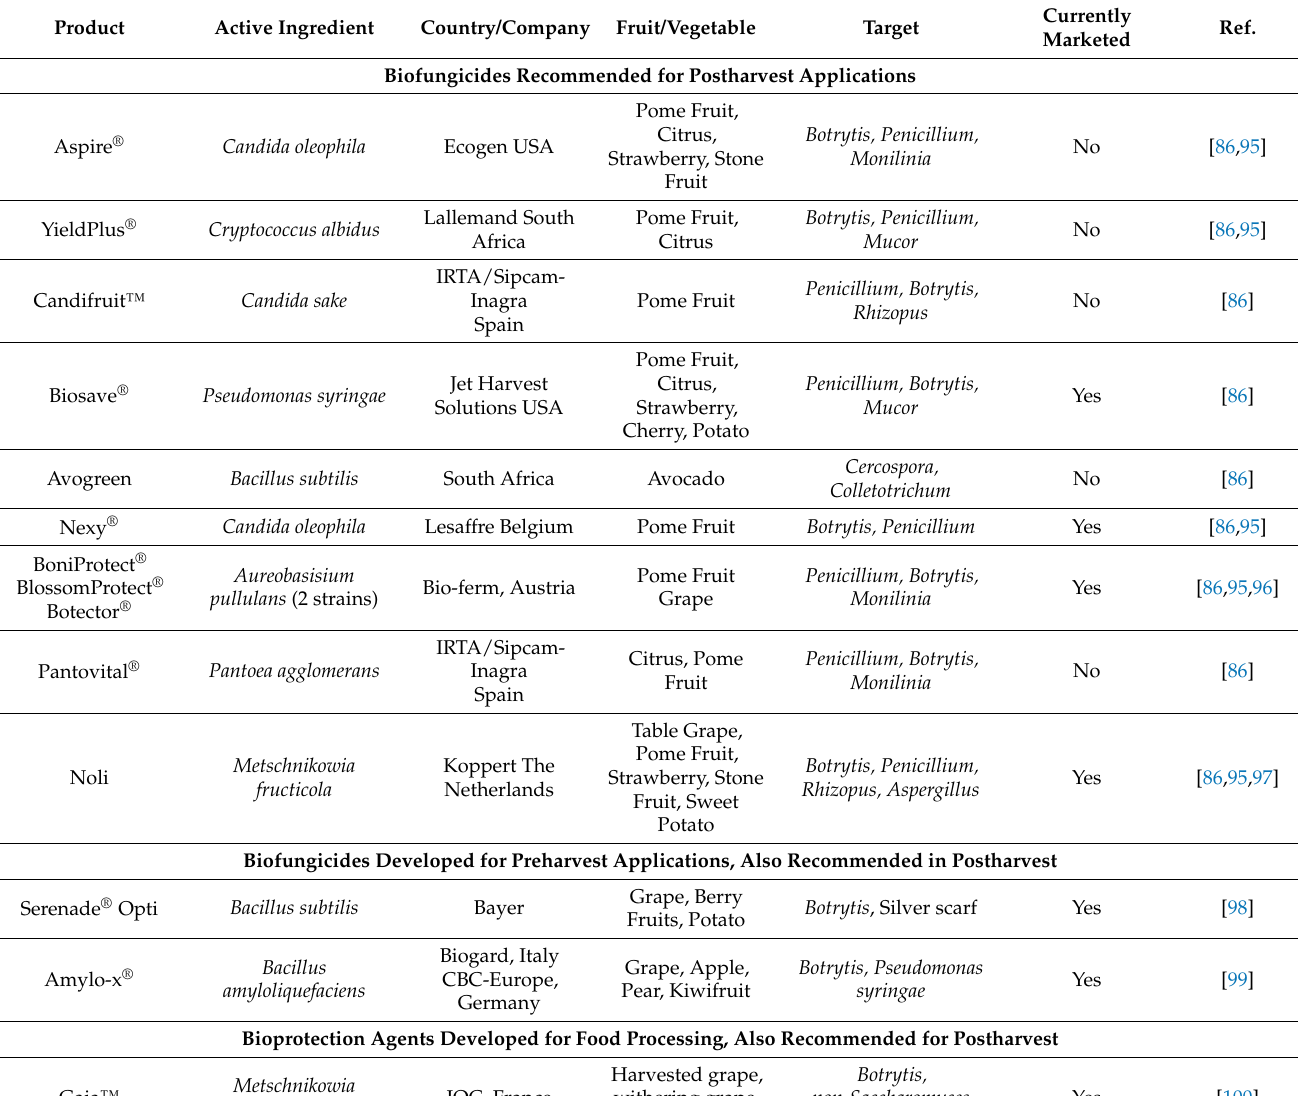
Table 3. Biocontrol-based products developed and marketed for postharvest